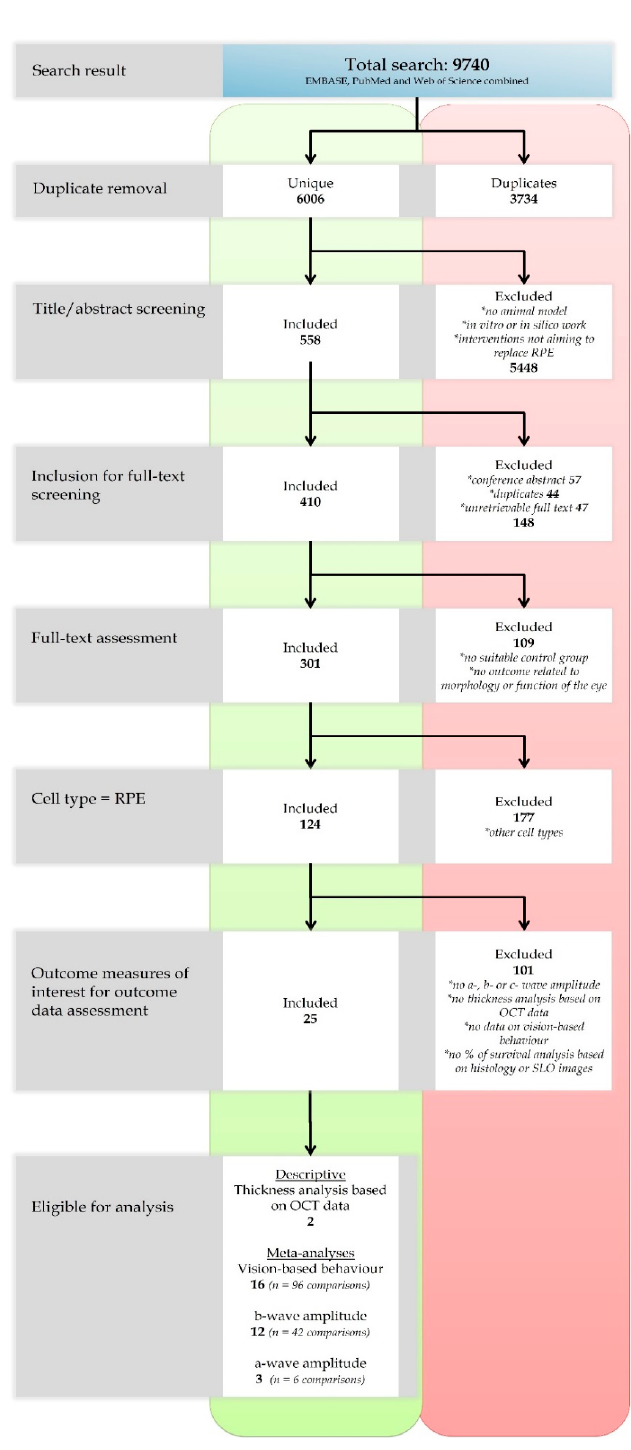
Figure 1. Flow diagram of the study selection progress. For details of the selection process: see text.